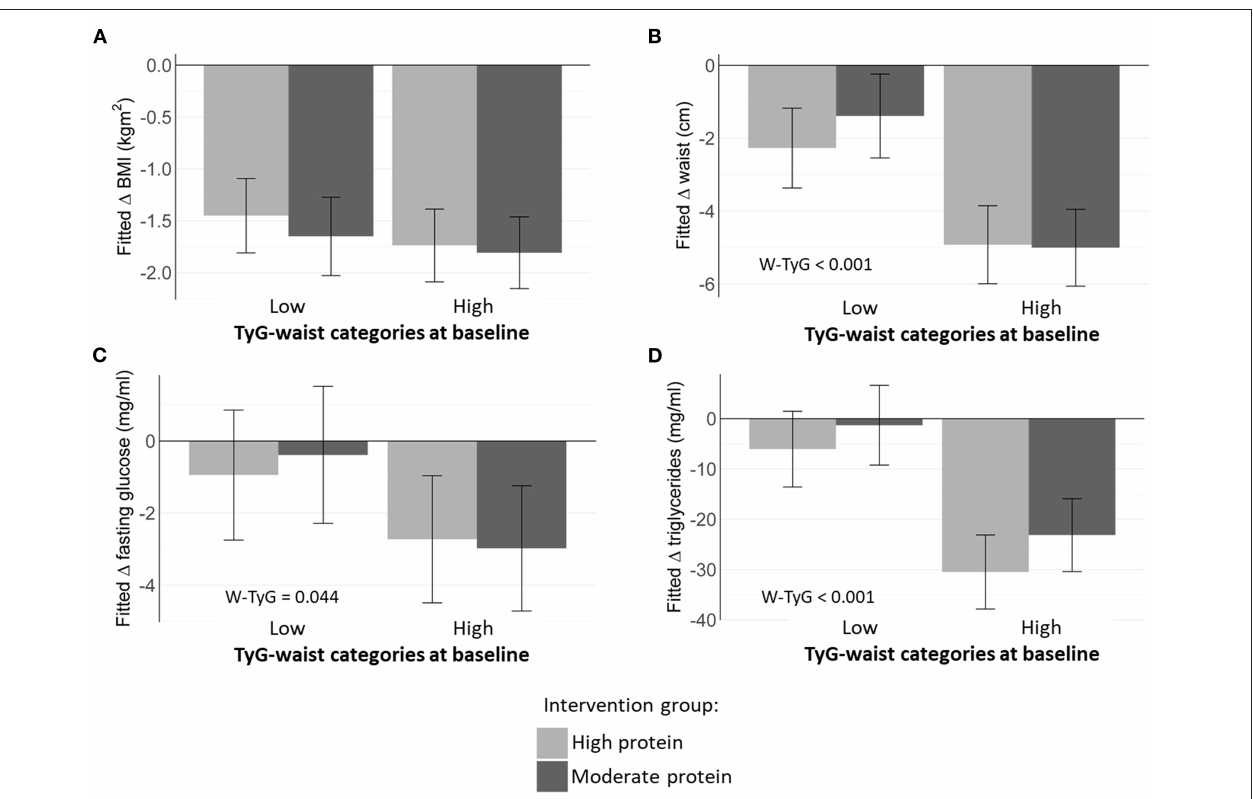
FIGURE 2 | Estimated marginal means of changes in metabolic markers depending on baseline TyG-waist categories and dietary protein intake (high vs. moderate intervention group). (A) Fitted change in BMI; (B) Fitted change in waist circumference; (C) Fitted change in fasting glucose; (D) Fitted change in